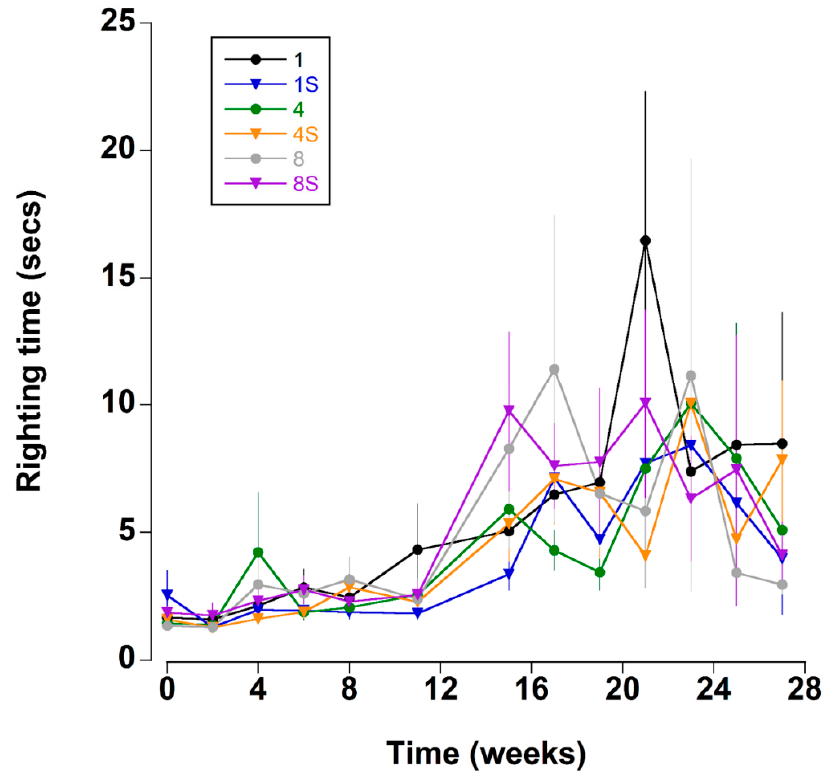
Figure 5. Righting time (s) (time taken to move from a ventrum up to dorsum up position) of C. maenas (mean ± SE) kept in densities of 1, 4 or 8 crabs, with (S) or without shelter ( n = 24 per treat- ment).